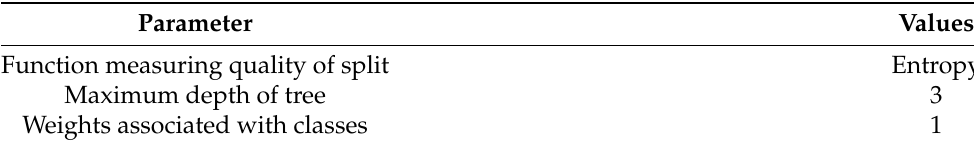
Table A1. Parameters of the decision-trees classifiers.